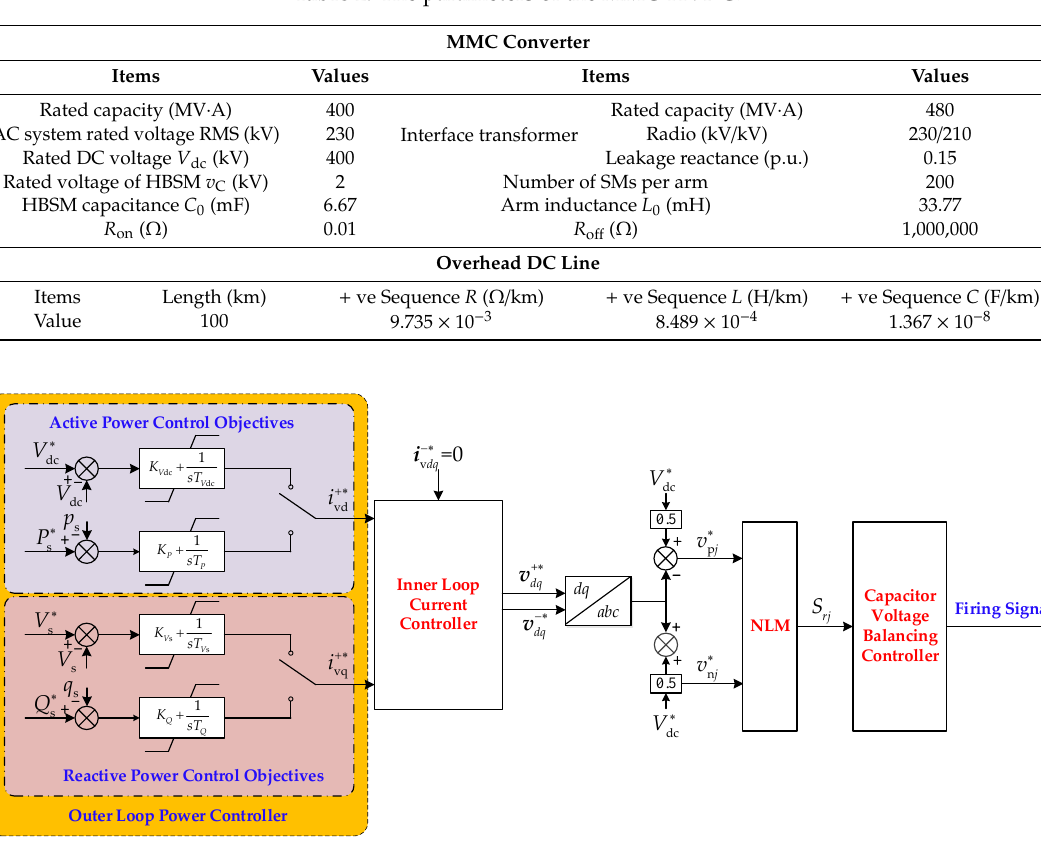
Table 2. The parameters of the MMC-HVDC.